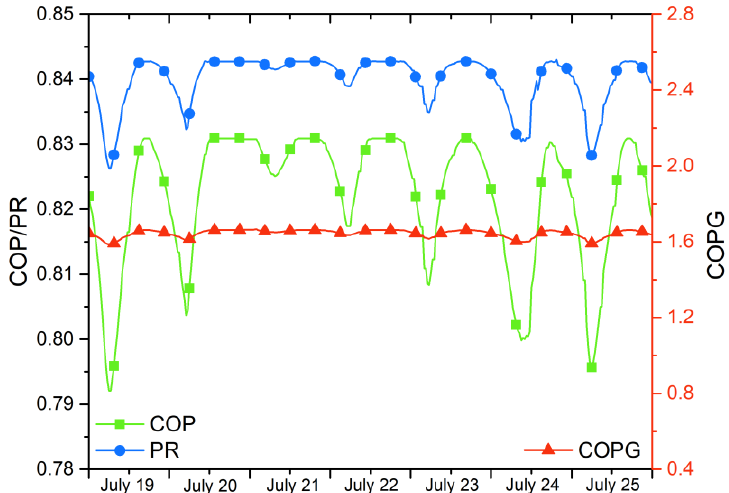
Figure 10. Performance of COP, COP G , and PR indicators during the critical summer week.